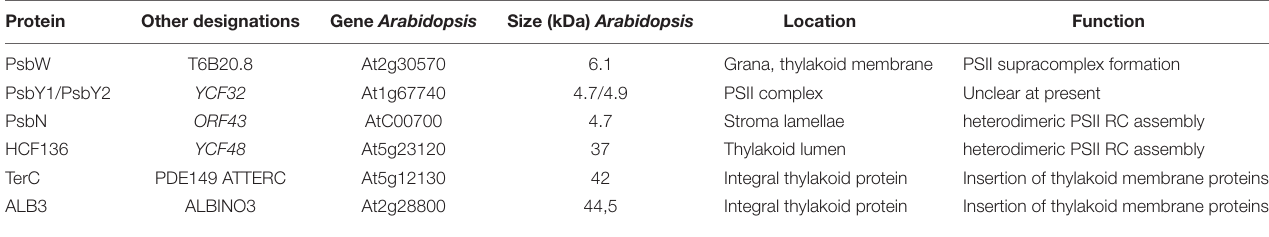
TABLE 1 | Summary of auxiliary proteins associated with PS II discussed in this update.